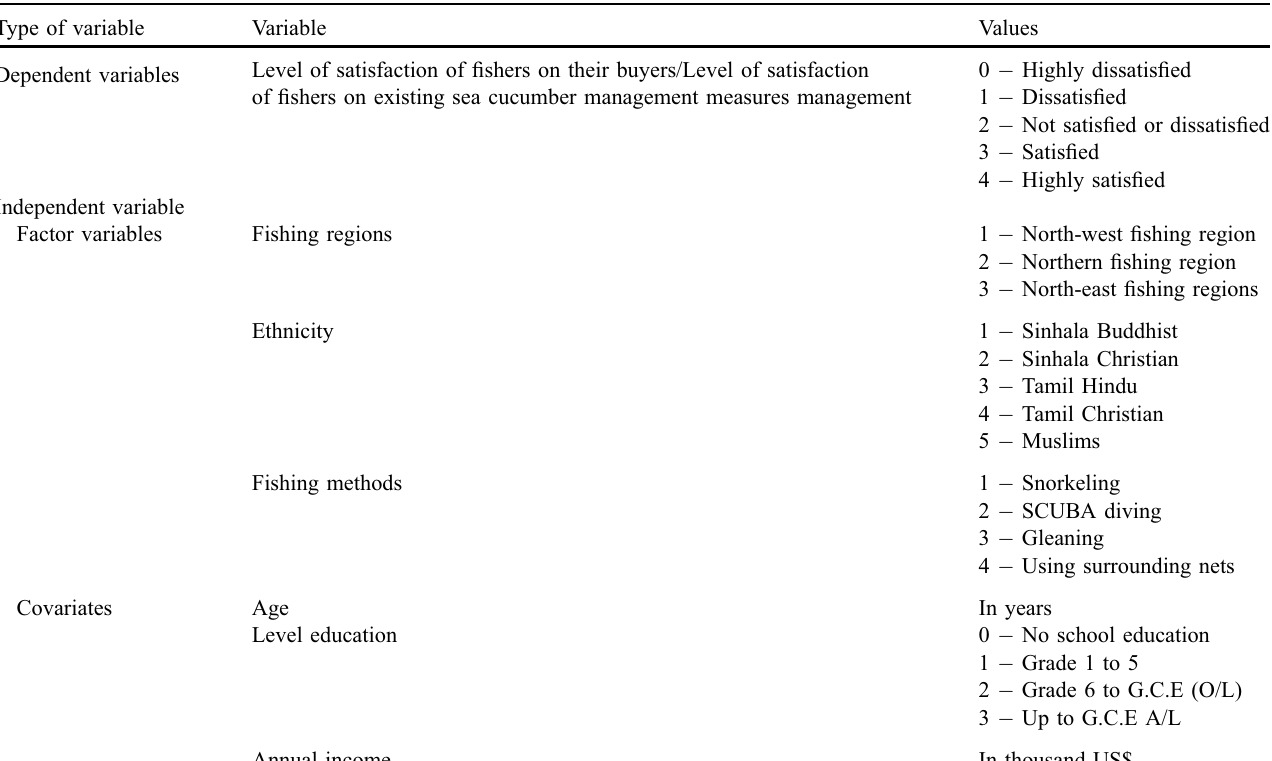
Table 1. Variables and values used to construct ordinal regression models to analyze the level of satisfaction of sea cucumber fi shers on their buyers and existing sea cucumber management measures in the three coastal regions of Sri